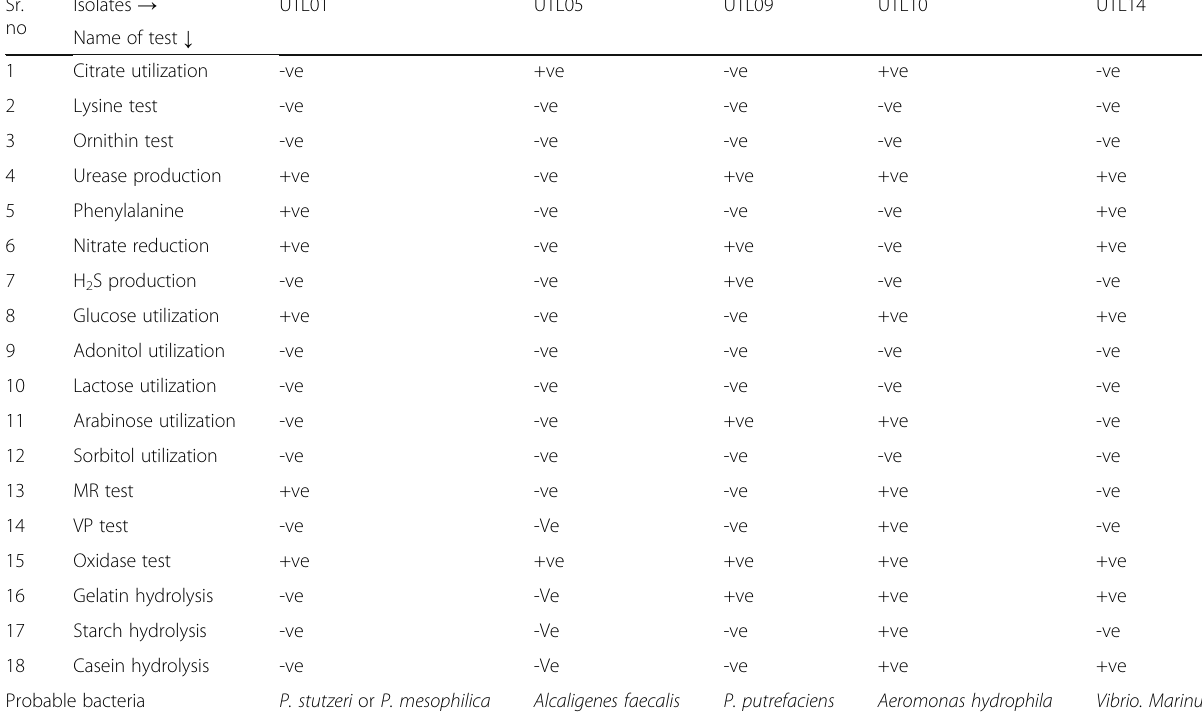
Table 6 Biochemical characterization of Gram-negative isolates from unused leech Sr. no